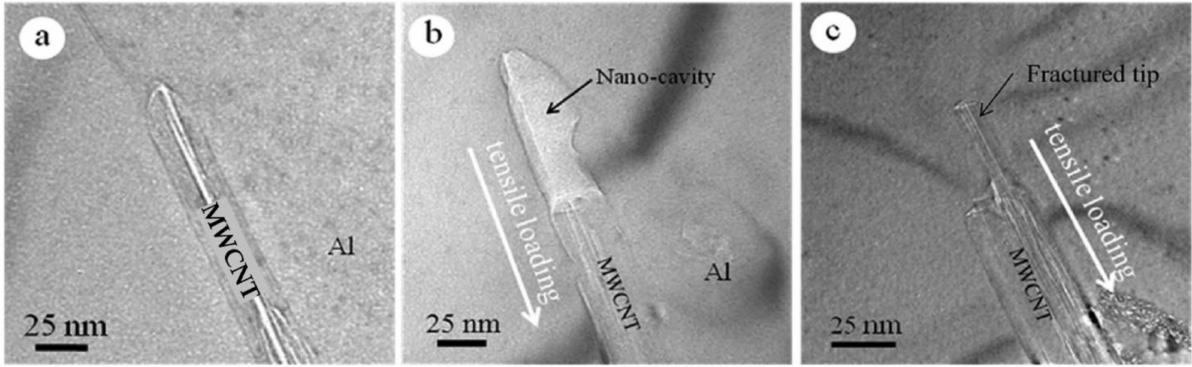
Figure 10. HRTEM images of the interface between the CNT and metal matrix ( a ) before and ( b , c ) after the tensile test. Adapted from [79] with permission from Elsevier, 2016.